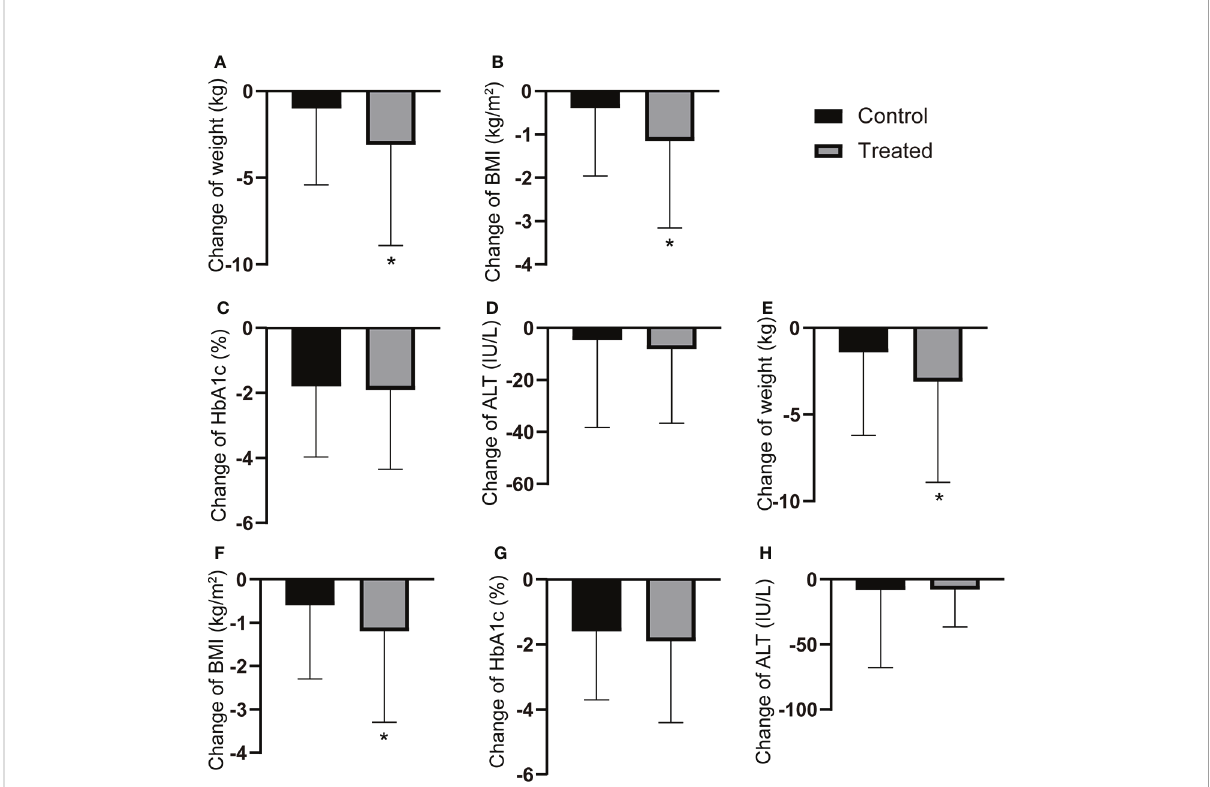
FIGURE 1 Changes of the clinical characteristics after 12-months follow-up. (A-D) The changes of body weight, BMI, HbA1c and ALT after 12-month follow-up in all T2DM patients with or without GLP-1RAs use. (E-H) The changes of body weight, BMI, HbA1c and ALT after 12-month fl ow-up in T2DM patients with or without GLP-1RAs use after PSM. *P < 0.05.